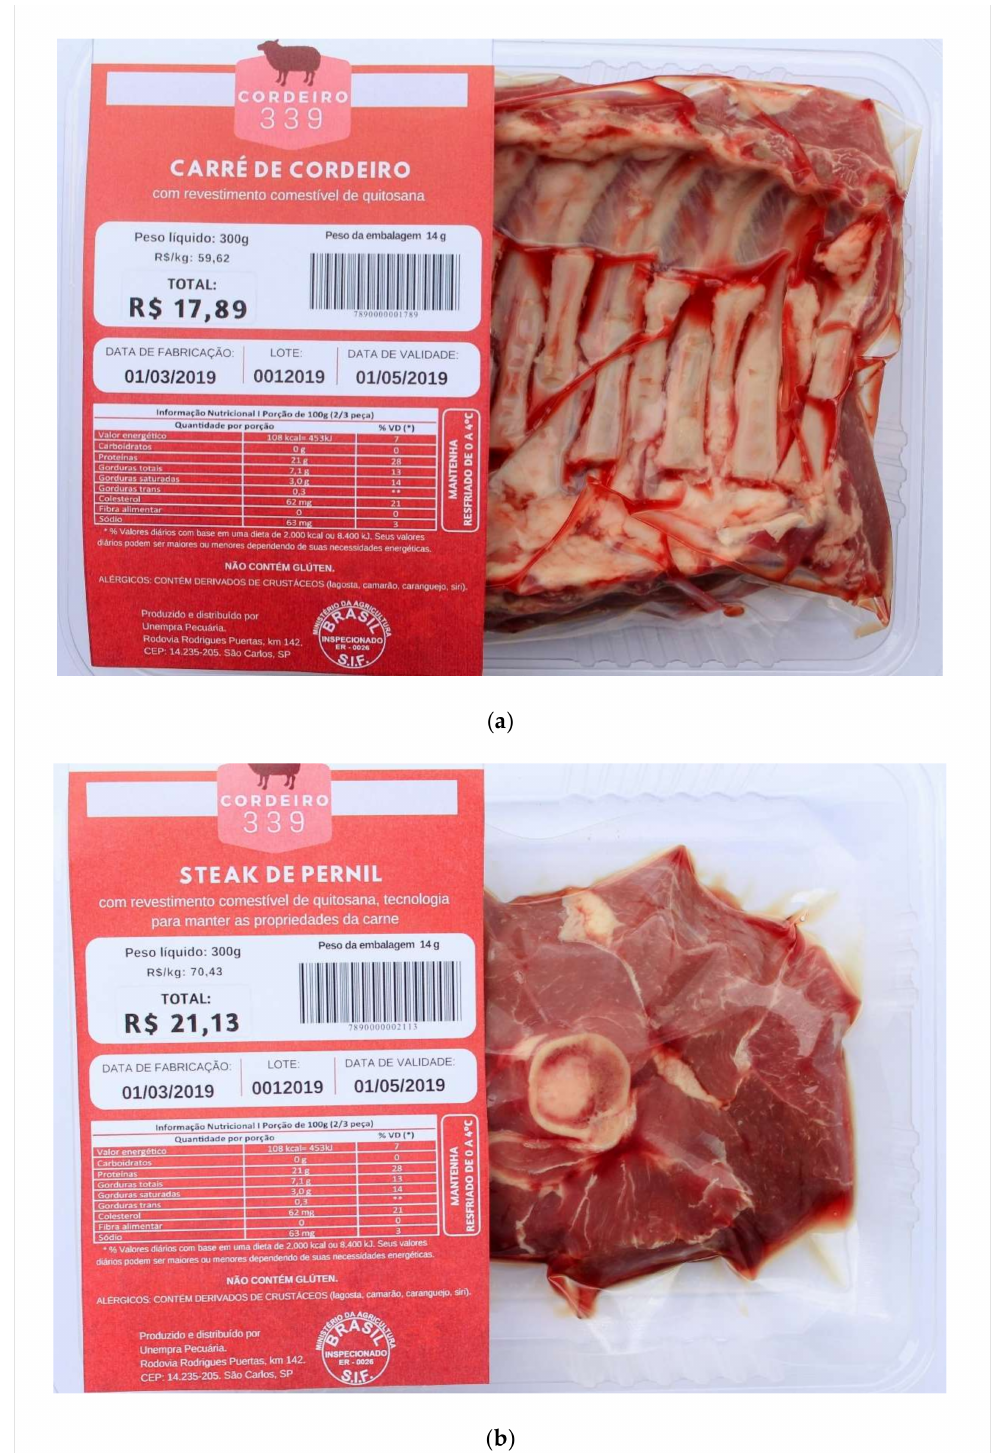
Figure 1. Examples of labels and packagings used in the study ( a ) treatment 8: chitosan/information, French rack cut (“carr é ”), low price and ( b ) treatment 9: chitosan/explained information, leg steak cut, high